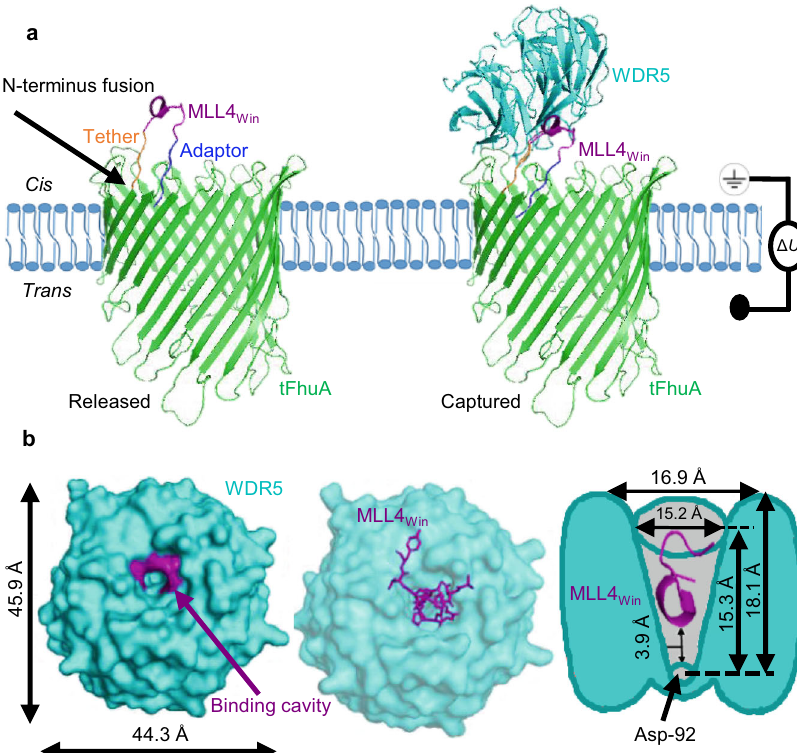
Fig. 1 The architecture of MLL4 Win tFhuA protein nanopore. a An MLL4 Win tFhuA protein nanopore reconstituted into a planar lipid membrane (light blue). This protein comprises a tFhuA protein nanopore (green), a fl exible Gly/Ser-rich hexapeptide tether (yellow), a 14-residue MLL4 Win peptide ligand (magenta), and a peptide adaptor (blue). This model was developed using Protein Data Bank fi les 1BY3 (FhuA) 28 and 4ERZ (MLL4 Win – WDR5) 32 . The left- and right-hand cartoons show the protein nanopore in the released and WDR5-captured substates, respectively. WDR5 is marked in cyan. The cis compartment of the measurement chamber is grounded. A transmembrane potential, Δ U , is applied. The black arrow indicates the N terminus of tFhuA that is fused to MLL4 Win via the fl exible tether. b On the left side, a top-view cartoon of WDR5 (in cyan) shows the binding cavity. Phe-133, Cys-261, and Ser-91 are colored in magenta. The central cartoon is the WDR5-MLL4 Win complex. MLL4 Win (in magenta) occupies the cavity of WDR5. On the right side, there is a cross-section schematic of the conical WDR5 cavity (in gray). MLL4 Win (magenta) partitions into the WDR5 cavity. This schematic is not on the same scale with the other